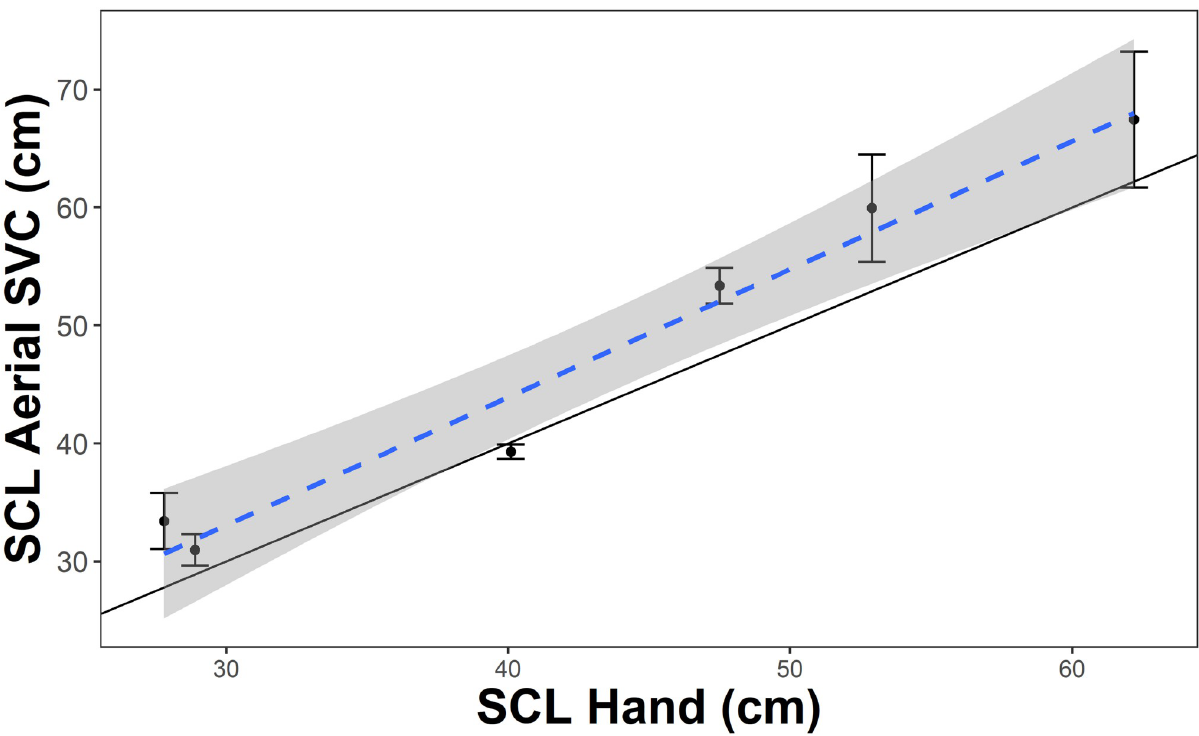
Fig 7. Comparison of hand measurements to SVC-UAV for green sea turtles (n = 6) from the field trial in Eleuthera, Bahamas. The dashed line and gray shaded area are the linear regression and standard error, respectively. The solid black line is the 1:1 line for the hand and SV-UAV measurements; points that fall on this line have equivalent measurements for both